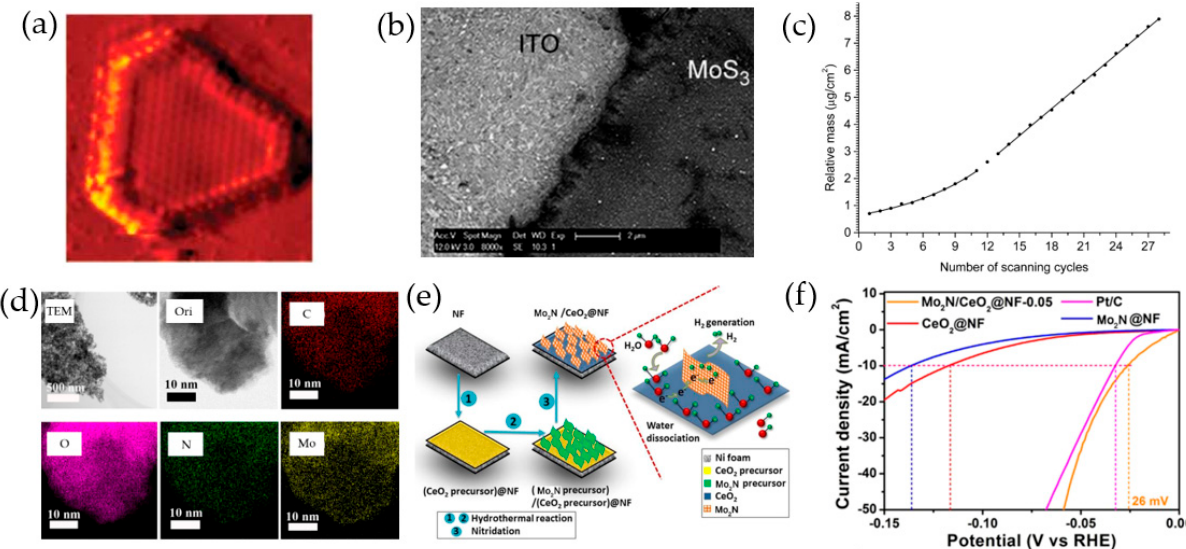
Figure 4. ( a ) STM image of atomically re-dissolved MoS 2 particle on Au(111) [170]; ( b ) electron micrograph of MoS 3 -CV film on ITO [172]; ( c ) CV scan dependency of the mass of MoS 2+x film [174]; ( d ) TEM images (TEM, Ori) and EDS mapping of Mo carbonitride [194]; ( e ) synthetic process of Mo 2 N/CeO 2 @NF [196]; ( f ) polarization curves of Mo 2 N/CeO 2 @NF-0.05, 20 wt% Pt/C, CeO 2 @NF and Mo 2 N@NF [196]. Ref. [170] with permission from copyright 2007 American Association for the Advancement of Science, Ref. [172] with permission from the Royal Society of Chemistry, and Refs. [174,194,196] with permission from copyright American Chemical Society. Table 3. Compared catalytic efficiencies of Mo-based HER electrocatalysts.